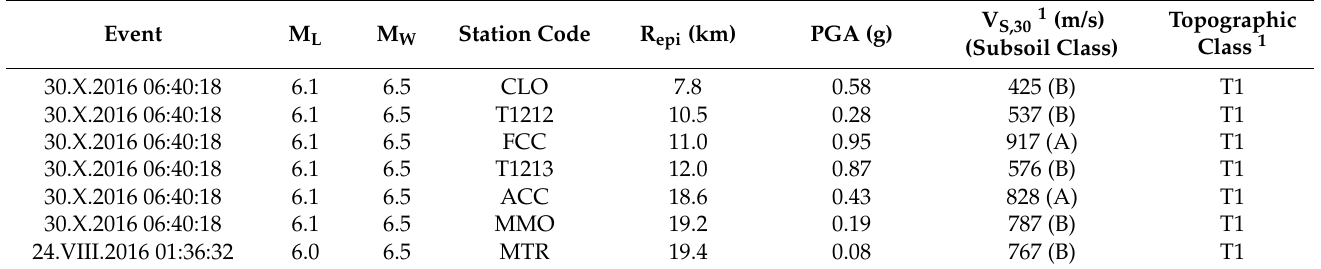
Table 3. Recorded ground motion obtained from the selection on ITACA database.